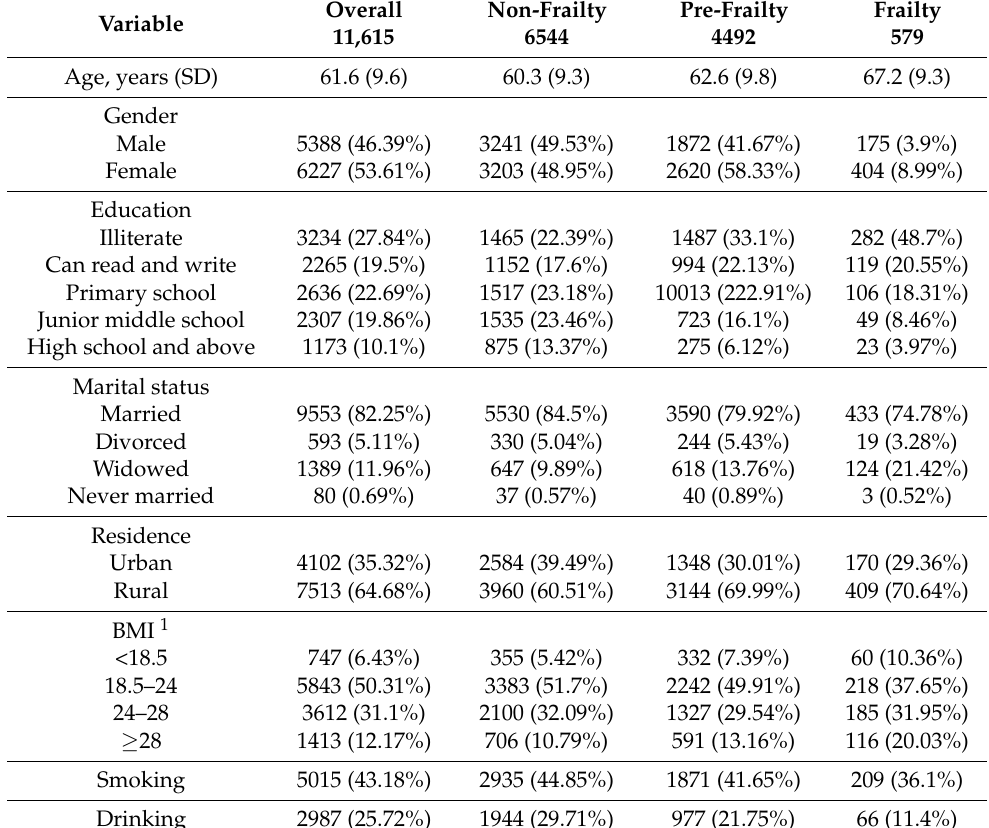
Table 1. Characteristics of the